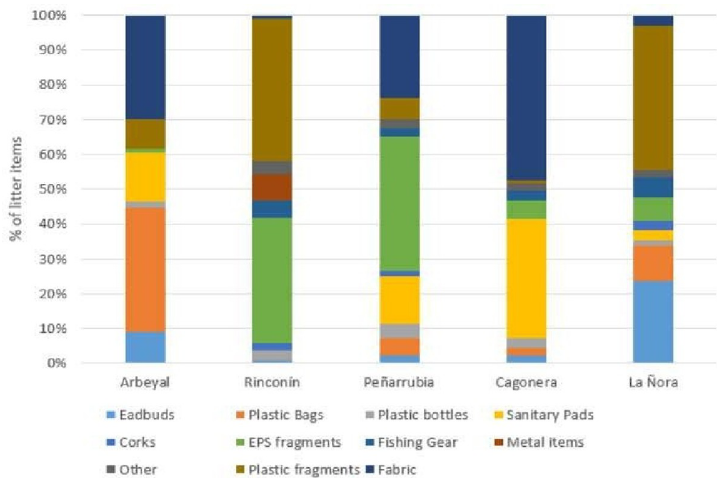
Fig 3. Litter composition in the five beaches analysed in this study, presented as proportion of each type of item.